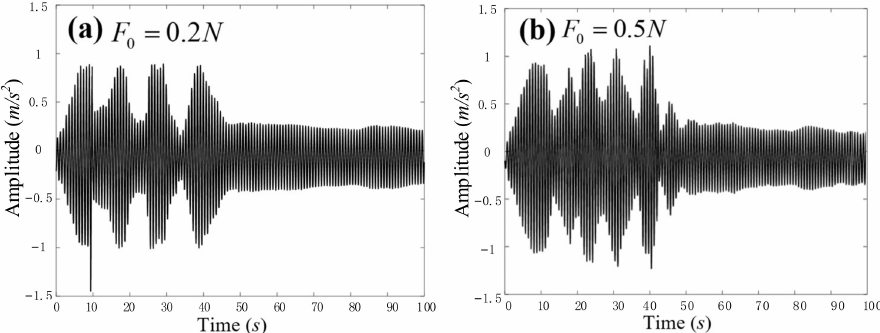
Figure 18. Effect of external excitation amplitude on primary resonance response of the flexible arm: ( a ) the external excitation amplitude F 0 = 0.2 N; ( b ) the external excitation amplitude F 0 = 0.5 N.